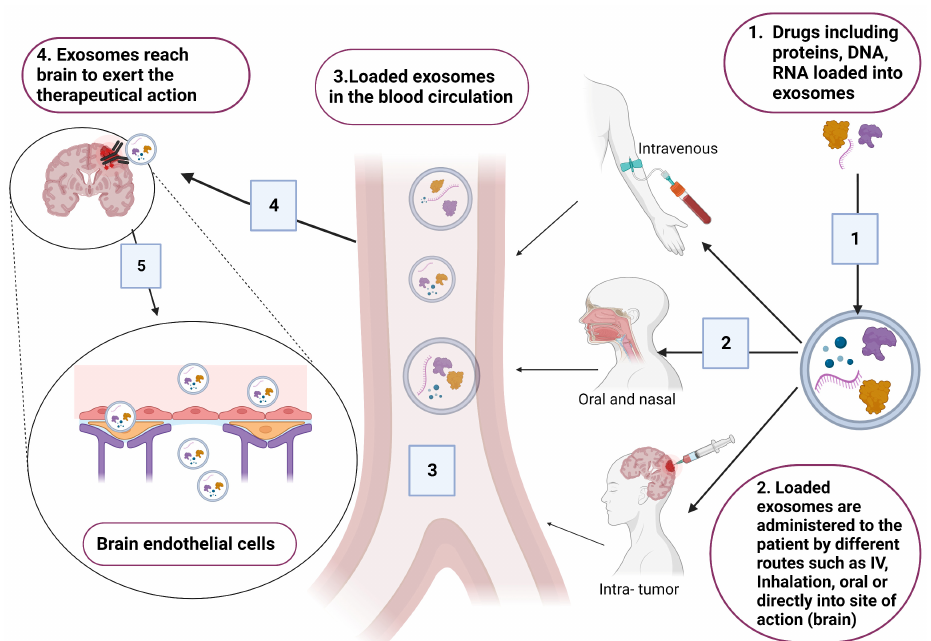
Figure 4. Schematic presentation for the incorporation of different therapeutical drugs, including DNA, RNA and proteins. Loaded exosomes are administered to patients based on the site of action (brain). Suitable routes that have good bioavailability are the intravenous route through injections, oral or inhalation, and intra-tumor injection. Original photo created with